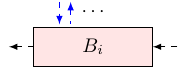
Figure 4: Representation of a single